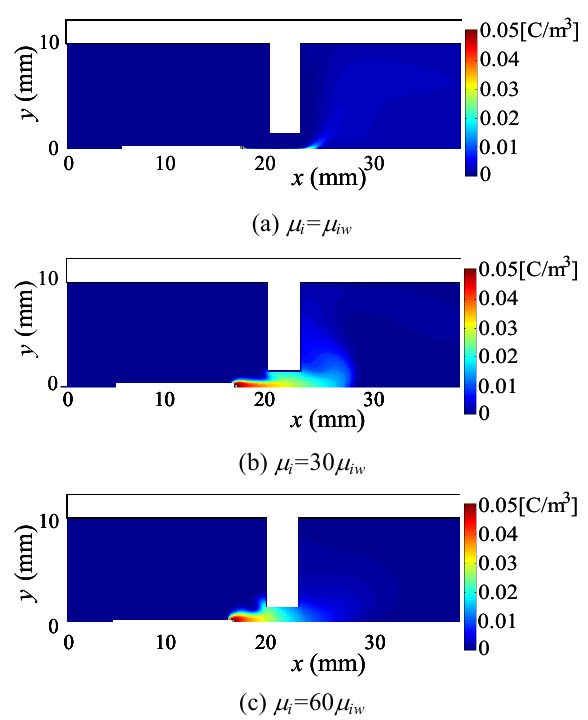
Fig.5 Effect of ionic mobility on charge density distribution ( V =10kV,